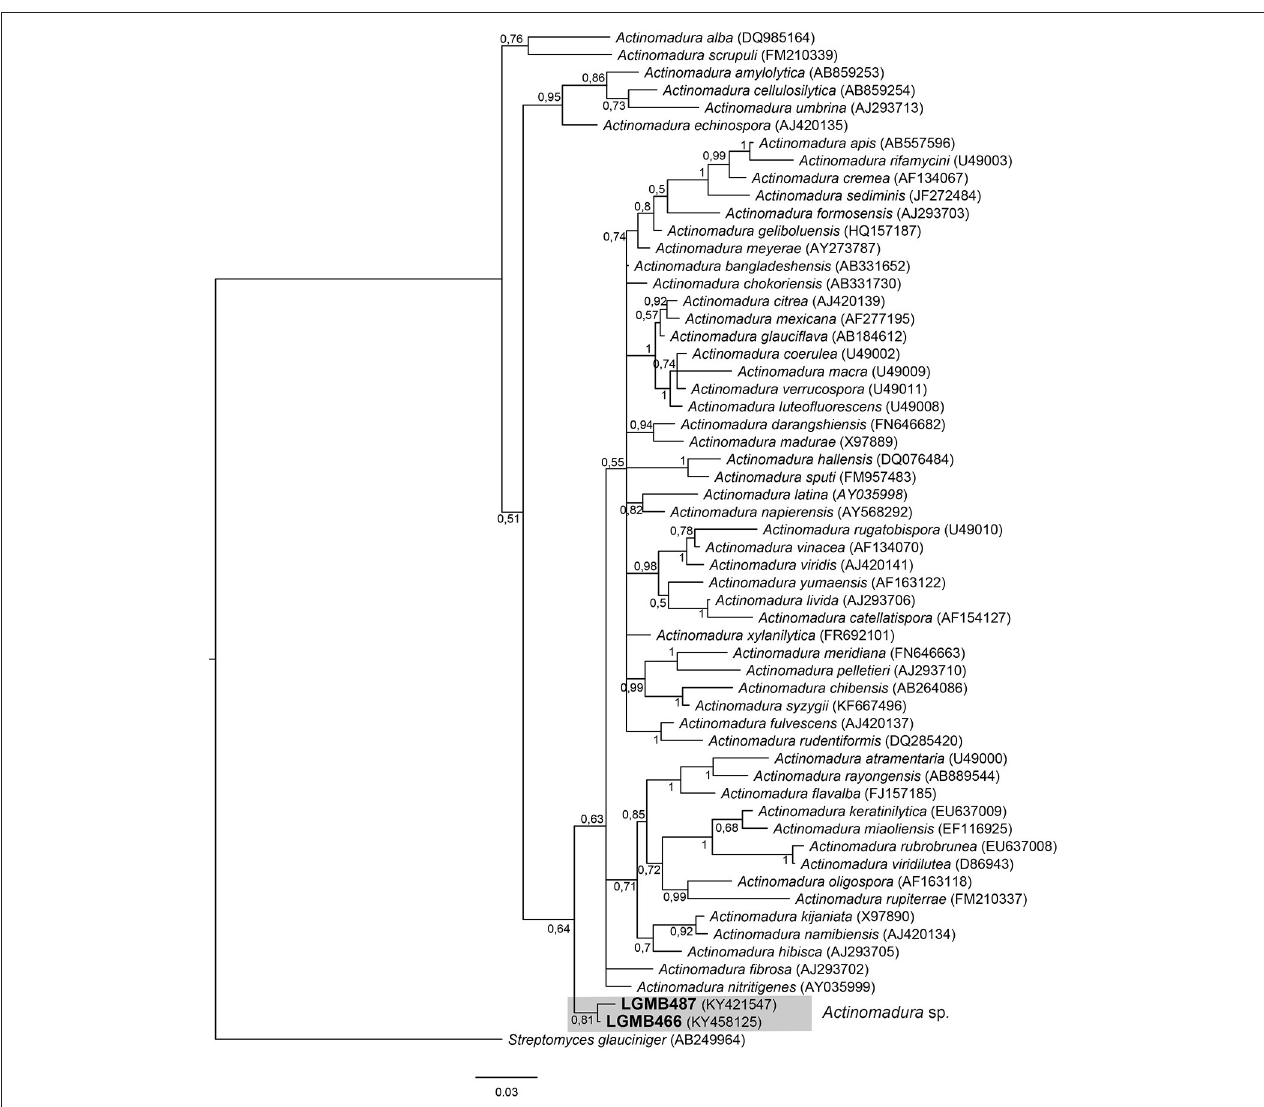
FIGURE 1 | Bayesian phylogenic tree based on 16S rRNA gene of LGMB466, LGMB487, and the 53 type strain of Actionomadura genus. Values on the node indicate Bayesian posterior probabilities. The species Streptomyces glauciniger was used as out group. Scale bar indicates the number of substitutions per site.